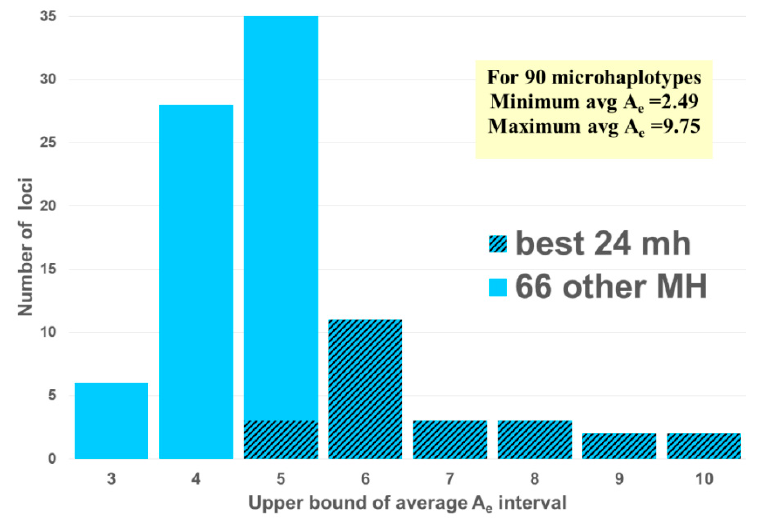
Figure 1. Yearly distribution of forensic papers about human microhaplotypes since the first in 2013 through 25 June 2022. Note that 2022 is outpacing 2021 so far. All fields were searched for “micro- haplotype” or “micro-haplotype” in PubMed and in the journal Forensic Science International Genetics Supplemental Series, which is not included in PubMed.